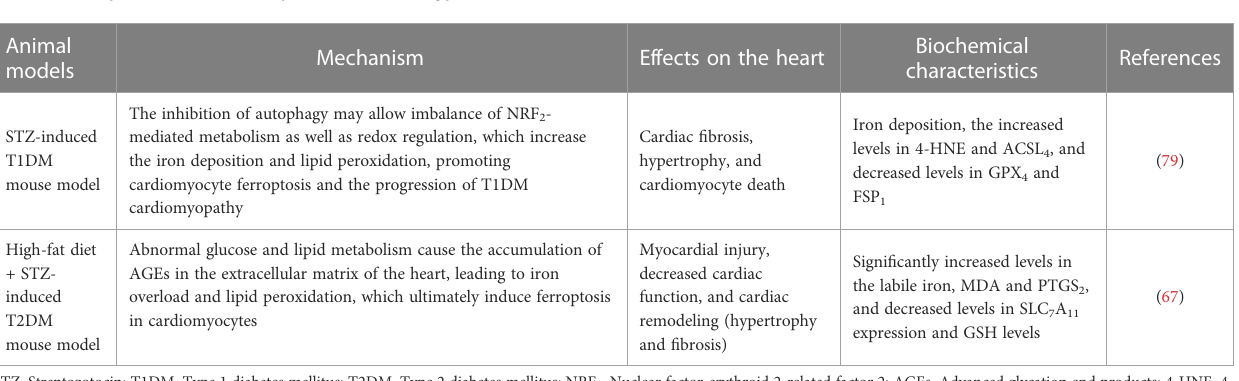
Mechanism Effects on the heart